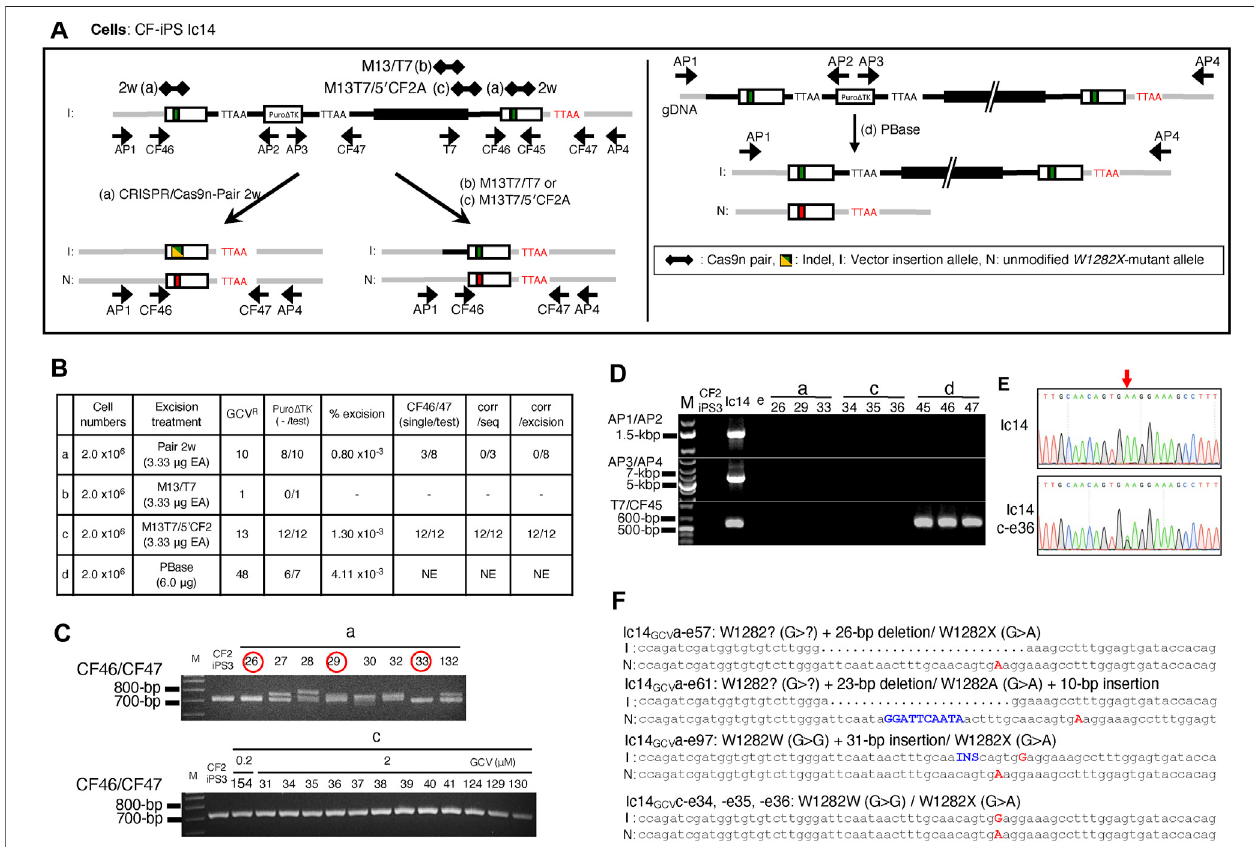
FIGURE7| SeamlessexcisionofVectorInsertionDNAbackbonewithCRISPR/Cas9nstimulatedIHR. (A) StrategyofexcisingtheinsertedplasmidDNAbackbone using theCRISPR/Cas9n-gRNAs targetingthejunctionofplasmiddonorbackboneand genomicDNA. Newly generated gRNA targeting tworegionswereused,oneof which cut thebackbone ofplasmid DNA (CRISPR/Cas9n-pair-M13/T7 gRNA, treatment b) and another targeted the junction between backbone and 5 ′ -homology arm of CFTR on donor DNA (CRISPR/Cas9n-pair-M13T7/5 ′ CF2 gRNA, treatment c). For comparison, CRISPR/Cas9n-pair-2w gRNA alone (treatment a) and PBase alone(treatmentd)werealsotested. (B) Summaryoftheexcisionef fi cienciesforeachstrategy.Ic14 cells(P8.13.14)weretransfectedfourtreatmentsandcellswithloss of the Puro Δ TK selected with GCV. (C) Selection of possible seamless excised clones with CF46/47 PCR. Clones a-e26, a-e29, a-e33 (circled in red), and all 12 clones from treatment c had single PCR amplicons indicating precise excision. (D) Con fi rmation of the removal of inserted plasmid DNA backbone DNA sequences using the vectorinsertiondiagnosticprimerpairsinrepresentativeclonesintreatmenta,c,andd. (E) SequencehistogramofAP1/4ampliconfromIc14andIc14c-e36.Redarrow points to W1282X mutation site. (F) Sequence of representative clones screened from Ic14 clones with excised inserted backbone by treatment a, and c. Red capital letter shows W1282X mutation site. All three Ic14GCVa clones have indel in corrected allele at upstream of W1282X mutation site shown as dot (deletion) or blue letter (insertion). All three Ic14GCVc clones have corrected and uncorrected allele without indels.